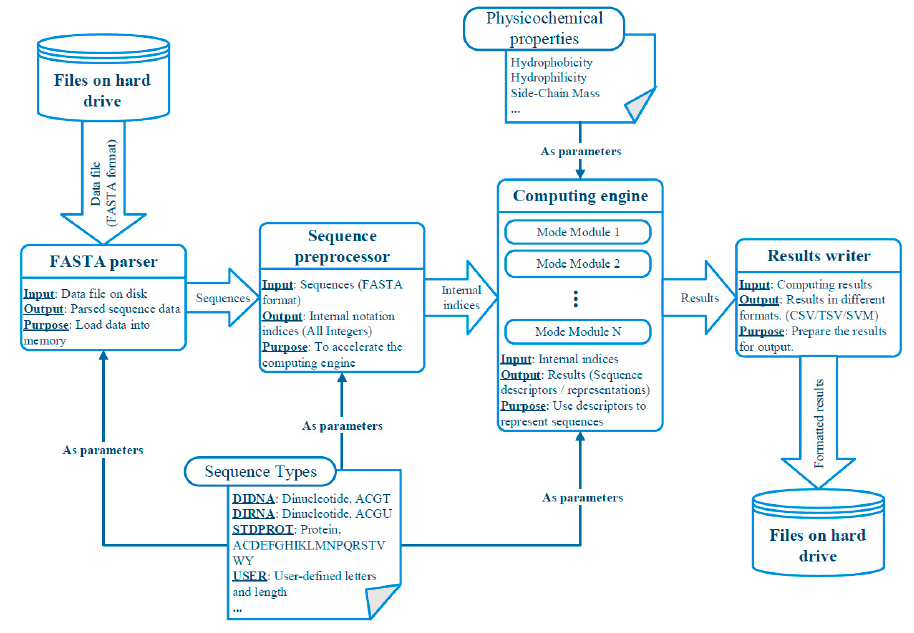
Figure 3. The abstracted software design and data flow chart of UltraPse.